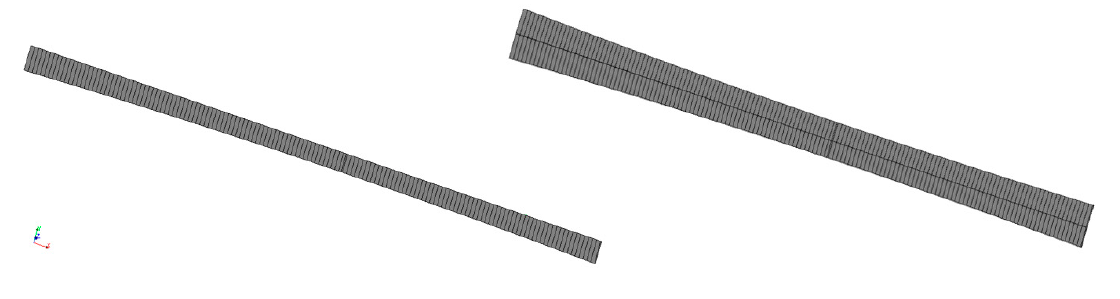
Figure 4. Shell models used for the three-point-bending (left) and torsion-bending (right) simulations.